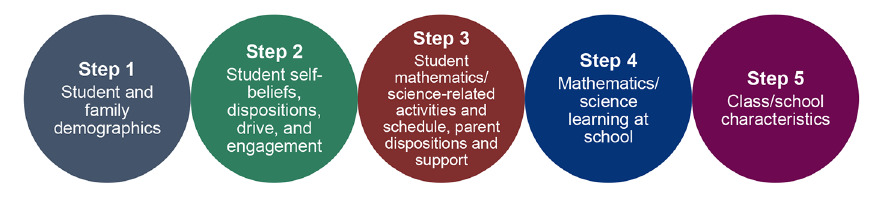
Fig. 1 Steps in building the hierarchical two-level binary logistic regression